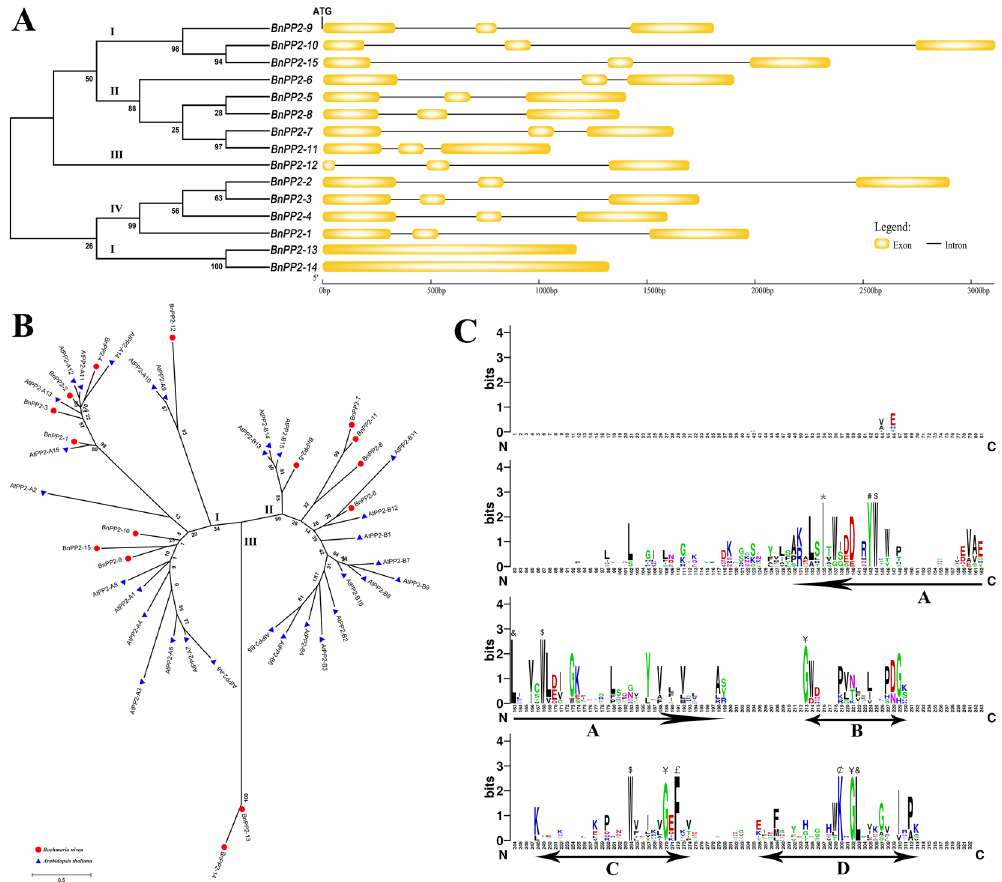
Figure 1. ( A ) Phylogenetic relationship of BnPP2 proteins and exon-intron structures of BnPP2 genes. All sequences were left-justified by their initiation codons (ATG) and ended with termination codons (Not marked in the figure). ( B ) Phylogenetic relationship of PP2 proteins in Boehmeria nivea and Arabidopsis thaliana . The red solid circle indicates Boehmeria nivea and the blue solid triangle indicates Arabidopsis thaliana . Bar = 0.5, their length indicates the level of divergence among sequences. ( C ) Web-Logo analysis conserved domain of PP2 proteins. The letters of different colors indicated different amino acid abbreviations. The height of letter indicated that the position of the amino acid conservatism, the higher the more conservative. The conserved motifs A through D of the PP2 domain were underlined. * Conserved Ile residues. # Conserved Tyr residues. $ Conserved Trp residues. & Conserved Leu residues. ¥ Conserved Gly residues. £ Conserved Phe residues. ¢ Conserved Lys